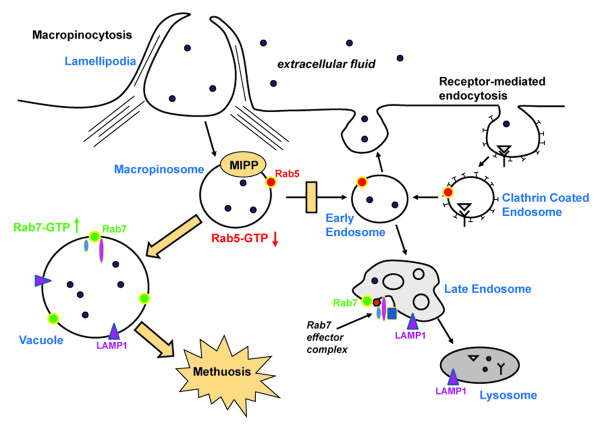
A working model for MIPP-induced methuosis suggested by the present studies: The earliest visible effect of the compound involves stimulation of macropinosome influx. Interaction of MIPP with unidentified components of the nascent macropinosomes results in a decline in active Rab5 and deficient delivery of macropinosomes to the early endosome sorting compartment. This precludes recycling or maturation to normal multivesicular and late endosomes. The abnormal macropinosomes undergo homotypic fusion and rapidly acquire some characteristics of late endosomes (e.g., LAMP1 and Rab7). However, they apparently lack key molecular components required for fusion with lysosomes. Consequently, they accumulate as vacuoles and eventually fill the cell, impairing metabolic function (decrease in ATP and mitochondrial membrane potential) and disrupting membrane integrity.